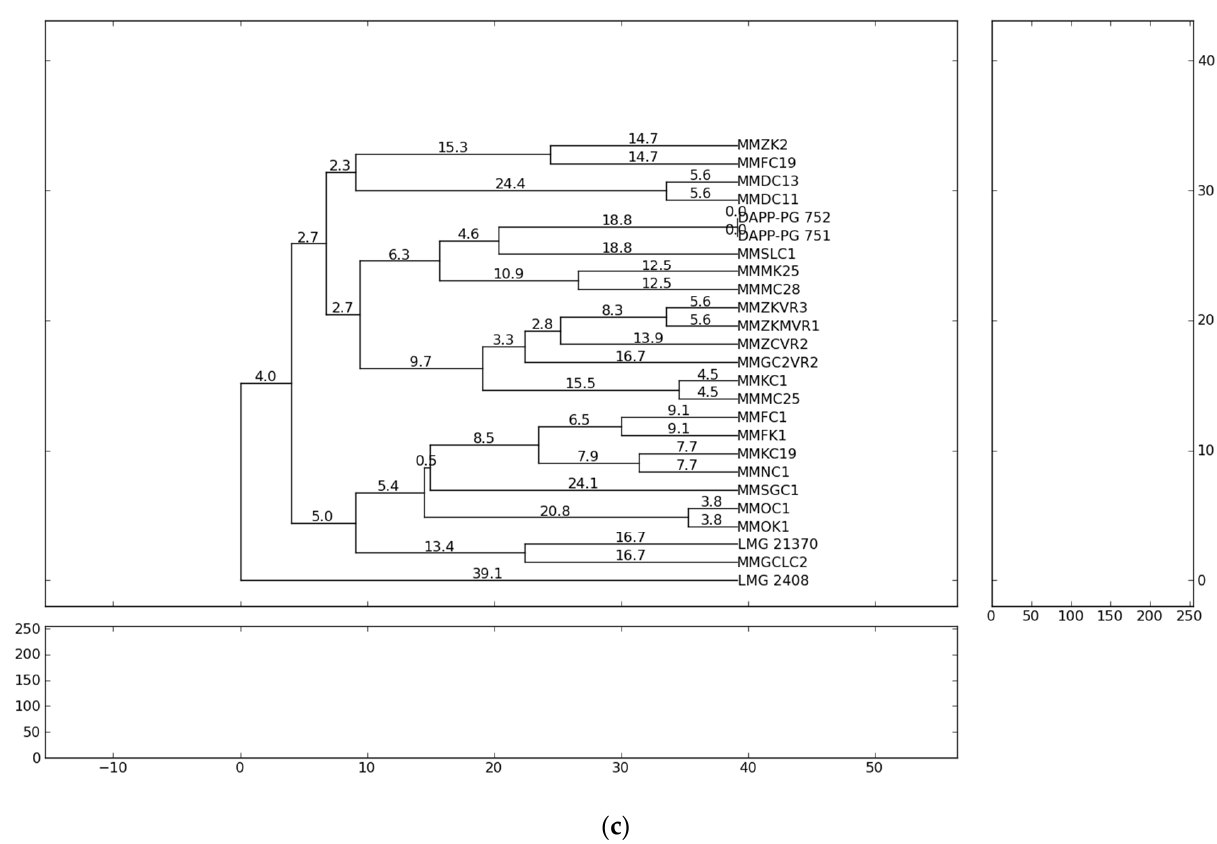
Figure 1. Dendrogram generated using UPGMA clustering method based on ( a ) ERIC-PCR, ( b ) BOX-PCR and ( c ) REP-PCR results for 21 isolates from Serbia and four reference strains. Genetic distances are described with numbers placed on the branches. Dendrograms were generated using PyElph version 1.3 (Python Software Foundation ® , Wilmington, DE,